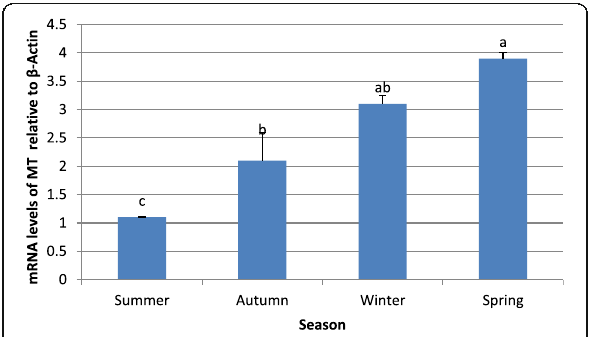
Fig. 3 Seasonal effect on mRNA expression levels of Metallothionein (MT) gene in liver tissue of Oreochromis niloticus. Bars indicate the standard error. Mean values with unlike superscript letters were significantly different ( p ≤